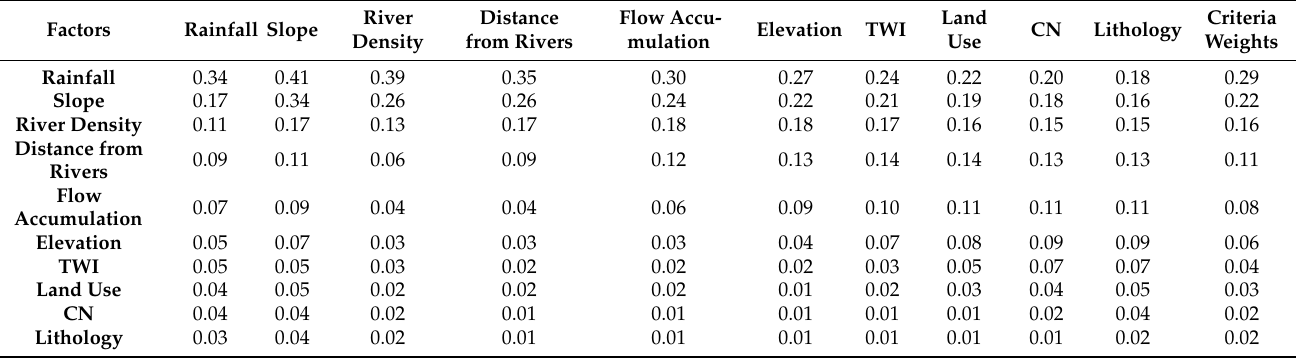
Table 3. Normalized pairwise matrix highlighting criteria weights used for conditioning